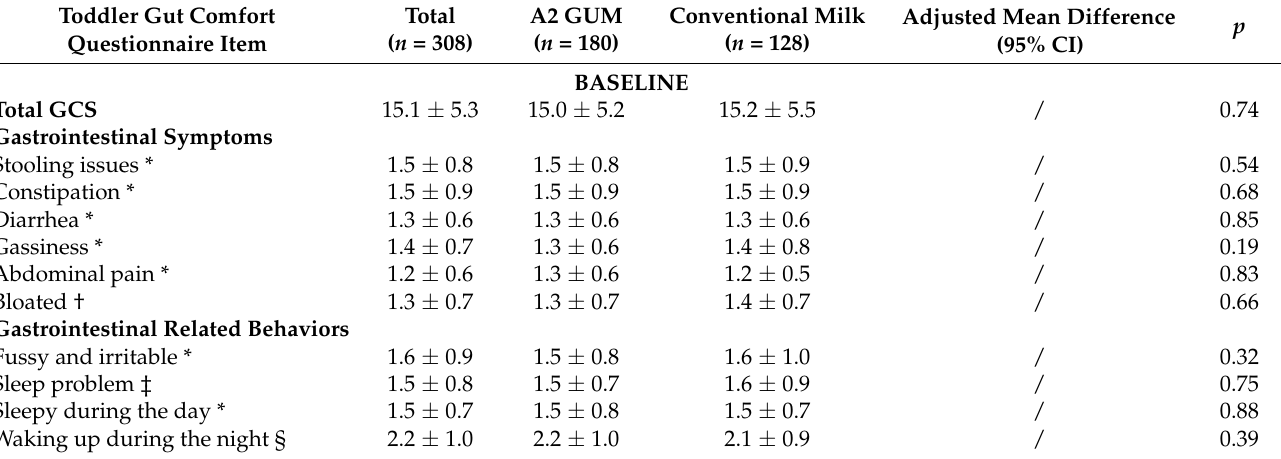
Table A2. Gastrointestinal items from Toddler Gut Comfort Questionnaire at baseline, on day 7 and day 14 among PPS